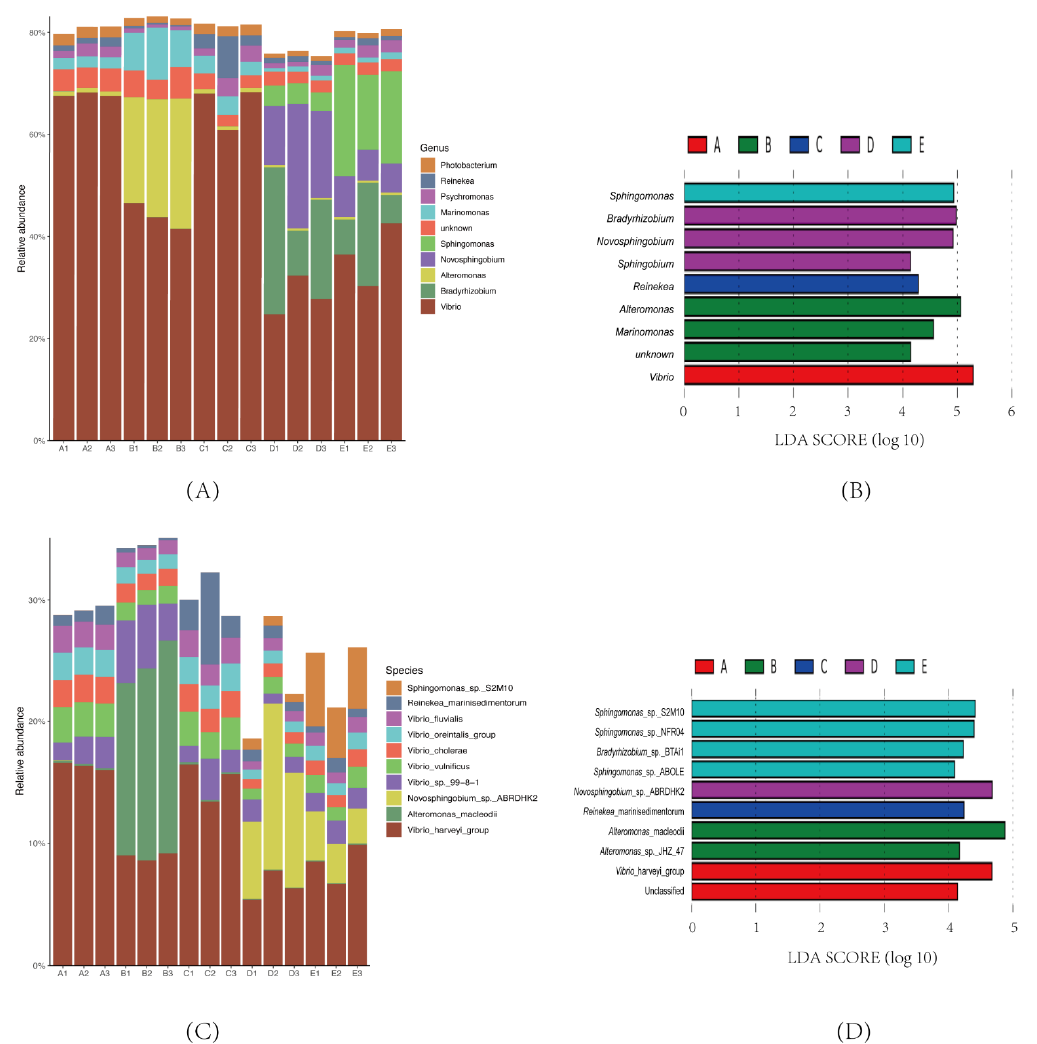
Figure 3. Taxonomic differences in S. fusiforme-related microbiome. Relative abundance bar plots of the top 10 genera ( A ) and linear discriminant analysis (LDA) score plot (score > 4) for microbes among five conditions at genus level ( B ). Relative abundance bar plots of top 10 species ( C ) and LDA score plot (score > 2) for microbes among five conditions at species level ( D ). Linear discriminant analysis effect size (Lefse) analysis was used to find the difference among groups. The LDA value shows the